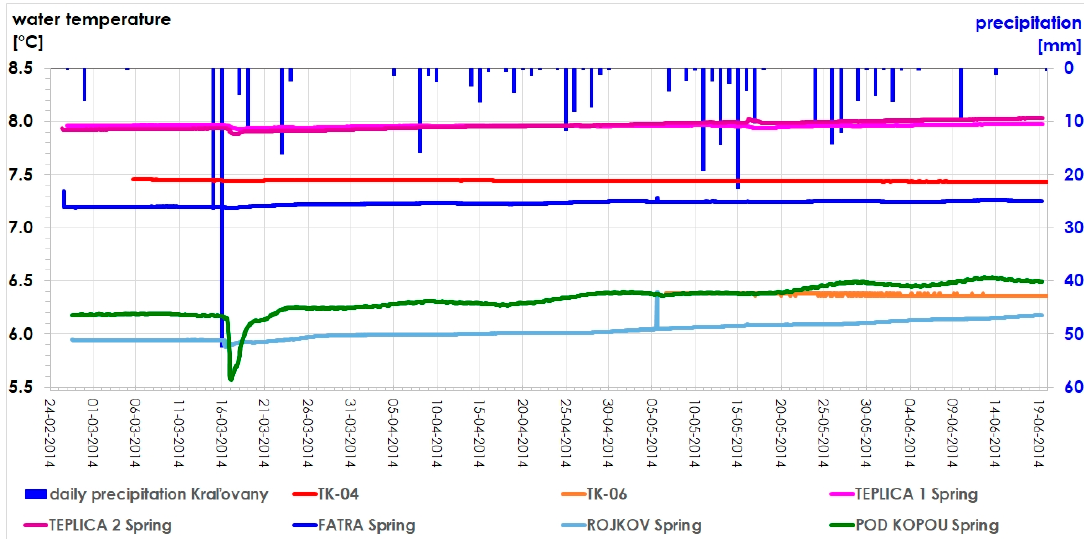
Figure 8. Groundwater temperatures in TK-04 and TK-06 boreholes and springs of the Kopa Mt. aquifer karstic springs in the period 24.02.2014–20.06.2014, together with daily precipitation totals at the SHMI 24020 station Kra ľ ovany in the same period.